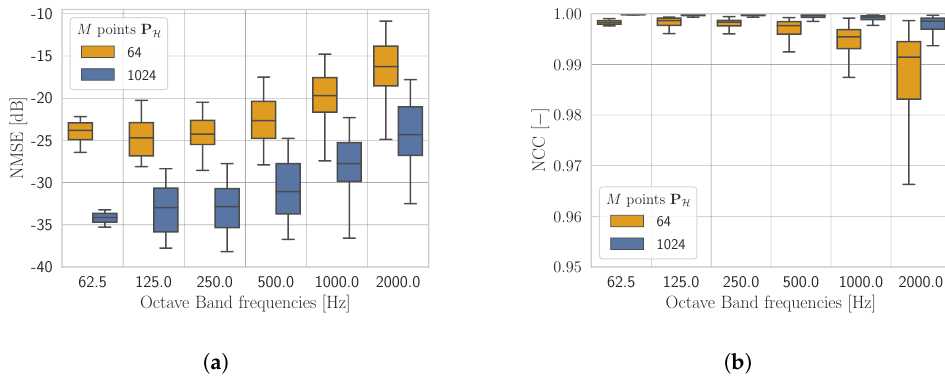
Figure 6. NMSE ( a ) and NCC ( b ) shown in octave bands given by the KHCNN estimates with P ( M = 64 ) and P ( M = 1024 ) at the input. H H